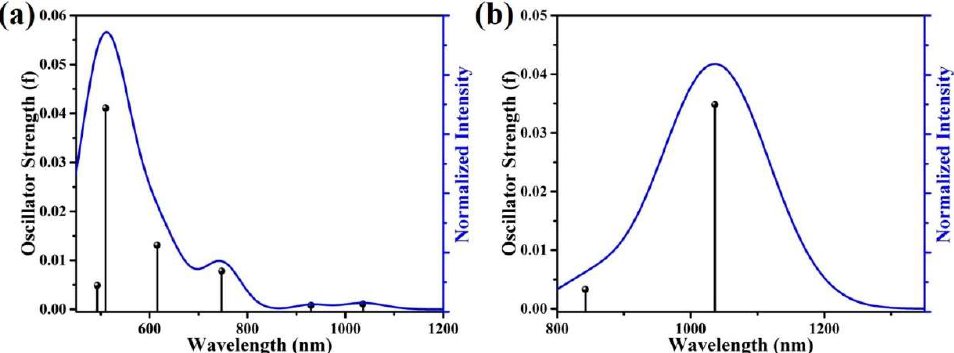
Figure 2. ( a ) Calculated absorption spectrum of PbS-doped 3MR; ( b ) calculated fluorescence spec- trum of PbS-doped 3MR.